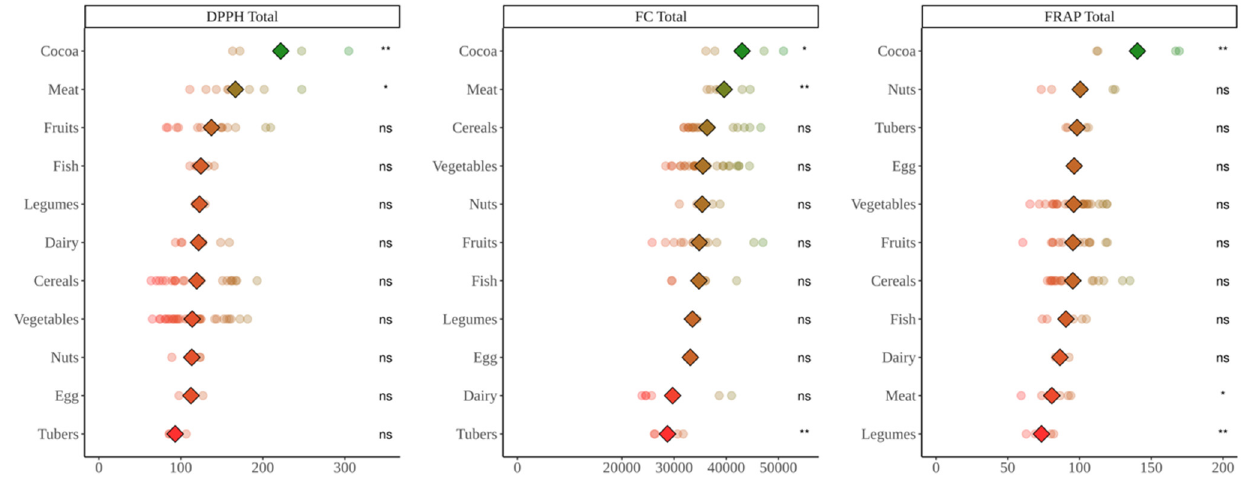
Figure 5. In vitro digestion values + in vitro fermentation values of food obtained after in vitro fermentation of selected foods with fecal material from obese children. DPPH expressed as mmol Trolox equivalents/kg(L) of food; Folin–Ciocalteu (FC) expressed as mg equivalents of gallic acid/kg(L) of food; FRAP expressed as mmol Trolox equivalents/kg(L) of food. Diamonds represent the mean antioxidant capacity of each group. Dots represent the antioxidant capacity of each food within the group. Statistical analysis was performed via Kruskal–Wallis test. Each of the groups were compared to the average of all of them (i.e., base-mean). Statistic labels: *— p < 0.05, **— p < 0.01, ns—not significant.